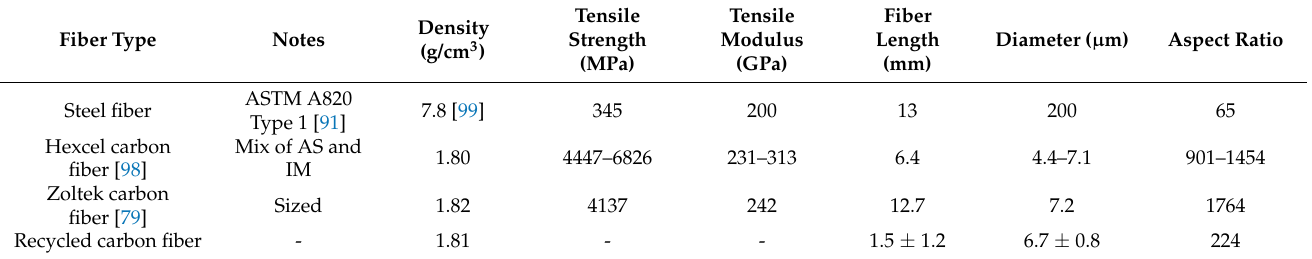
Table 2. Physical and mechanical properties of fibers used in UHPC mix